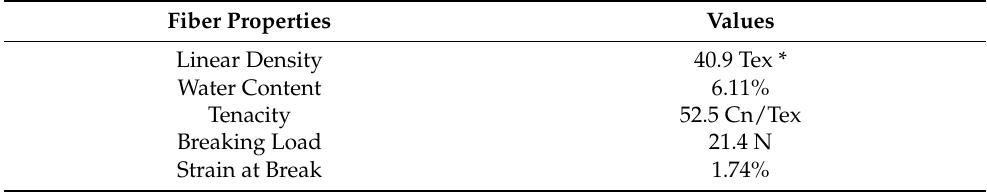
Table 2. Physical and mechanical properties of the fiber.